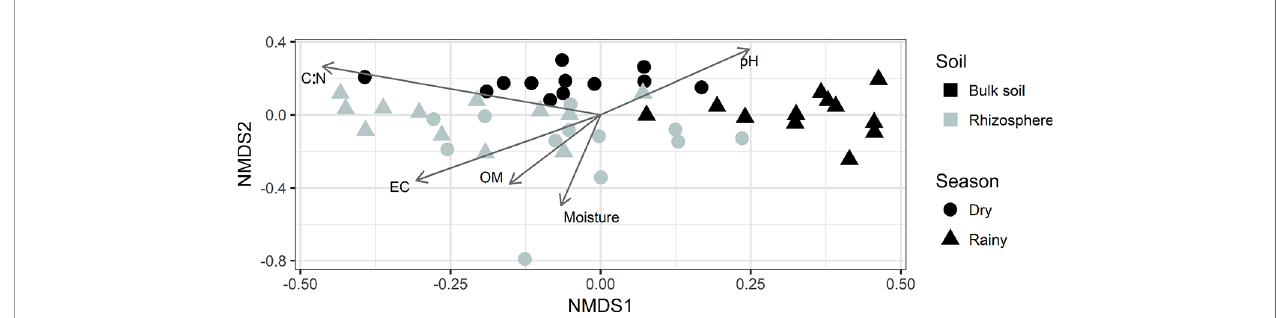
FIGURE 3 | NMDS analysis using relative abundance at a genus level. Arrows indicate the physicochemical properties that resulted in a signi fi cant relationship with the microbial community.